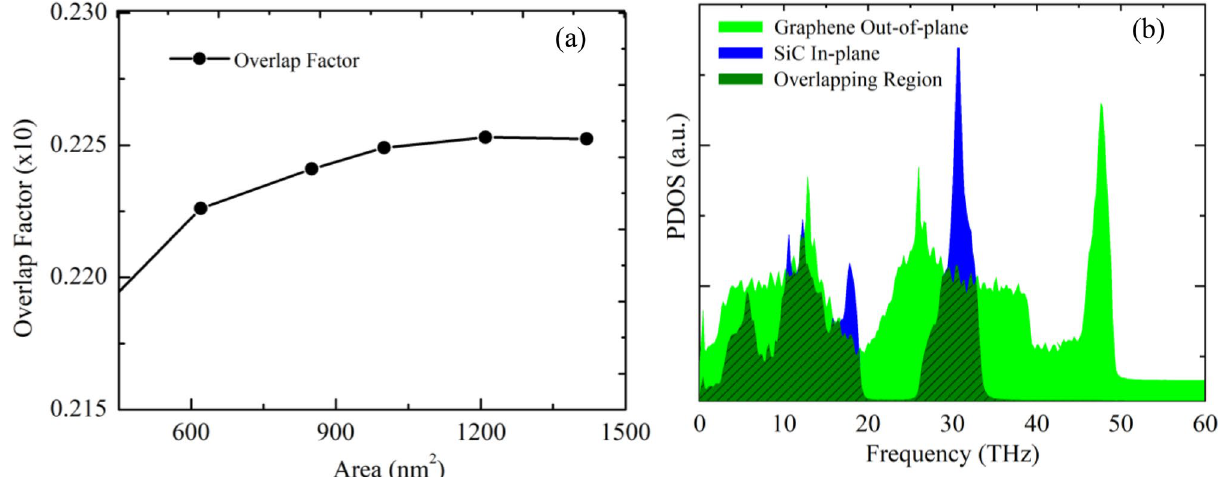
Figure 14. ( a ) Calculated overlap factor S as a function of the heterobilayer area. ( b ) PDOS of graphene Out-of- plane and SiC In-plane of 100 × 10.8 nm 2 graphene/2D-SiC vdWHs. The slant areas (olive) denote the overlap region between graphene out-of-plane and SiC